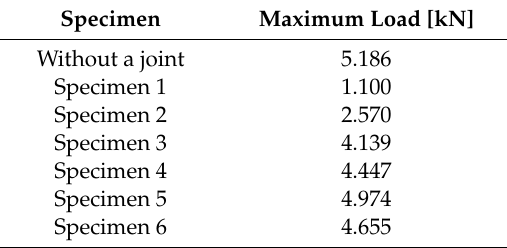
Table 3. Maximum loads of the steel wire rope and the six jointed specimens.